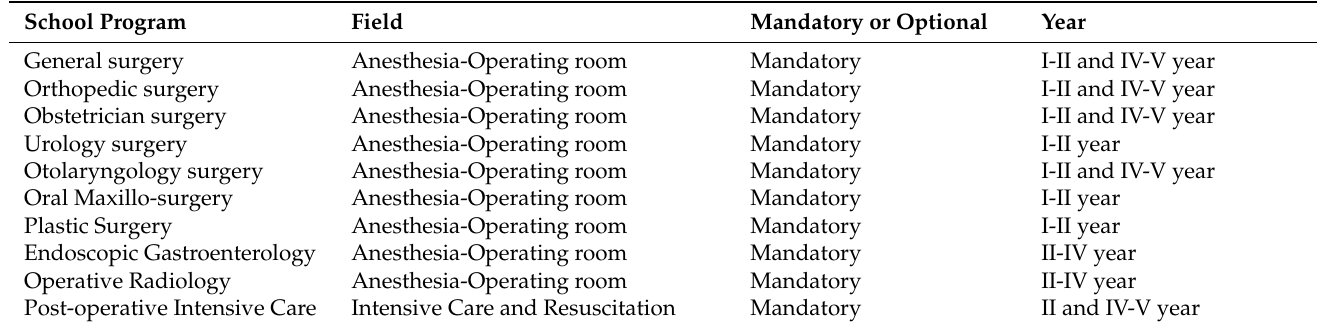
Table A3. Program of school of Anesthesia and Intensive Care of University of Modena and Reg- gio Emilia.